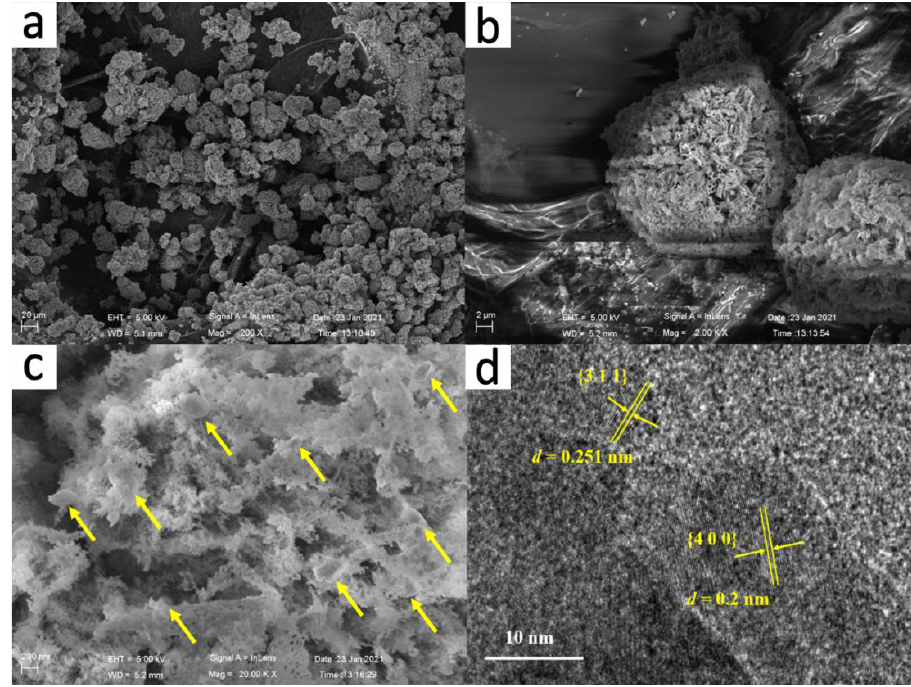
Figure 2. Representative SEM images ( a – c ), and HRTEM image ( d ) of the CF catalyst. The degradation efficiencies of different samples for RhB are displayed in Figure 3a.